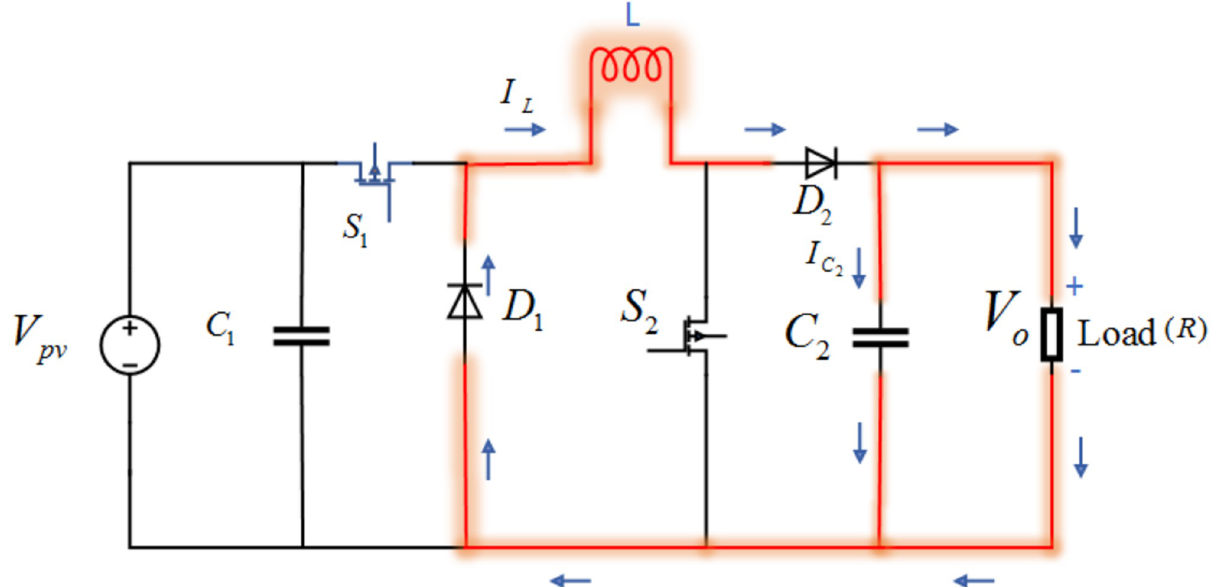
Fig 6. Circuit diagram of non-inverted buck boost